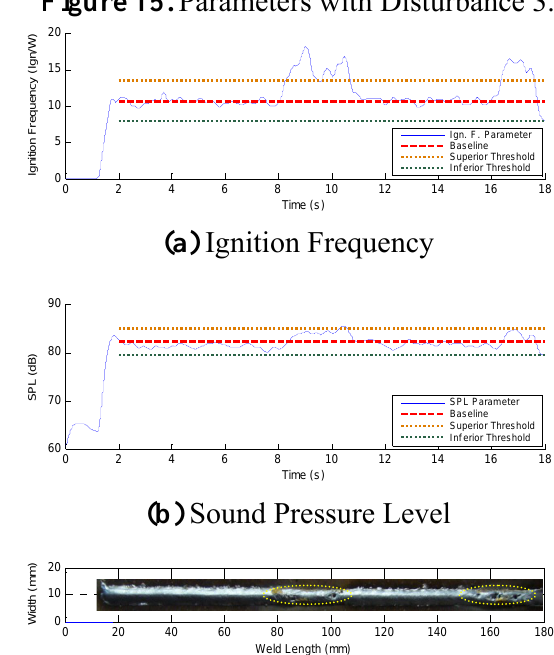
Figure 14. Parameters with Disturbance 2. Figure 15. Parameters with Disturbance